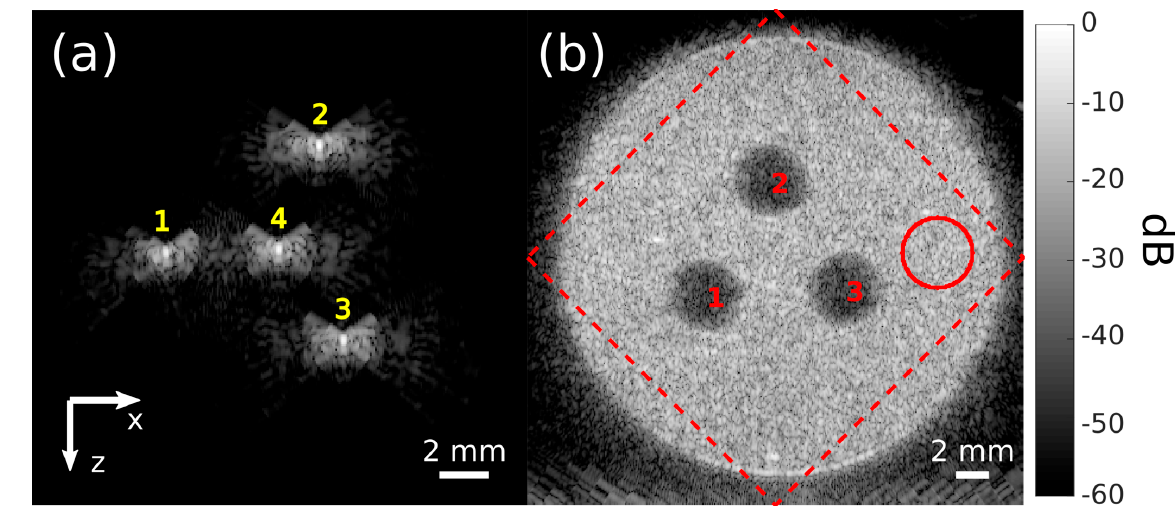
Figure 7. ( a ) A xz-image of Ph3 (20 mm × 20 mm); ( b ) xz-image of Ph2 (30 mm × 30 mm). Both xz-images are at y = 0 and centered on x = 0 and z = 25 mm. They correspond to acquisitions performed in straight transmit at Δ α 2 with L = 30 mm. Numbers identify the threads ( a ) and holes ( b ), respectively. The speckle zone considered to calculate the image contrast is designated with a red circle in ( b ). The images are displayed with − 60-dB dynamic range.